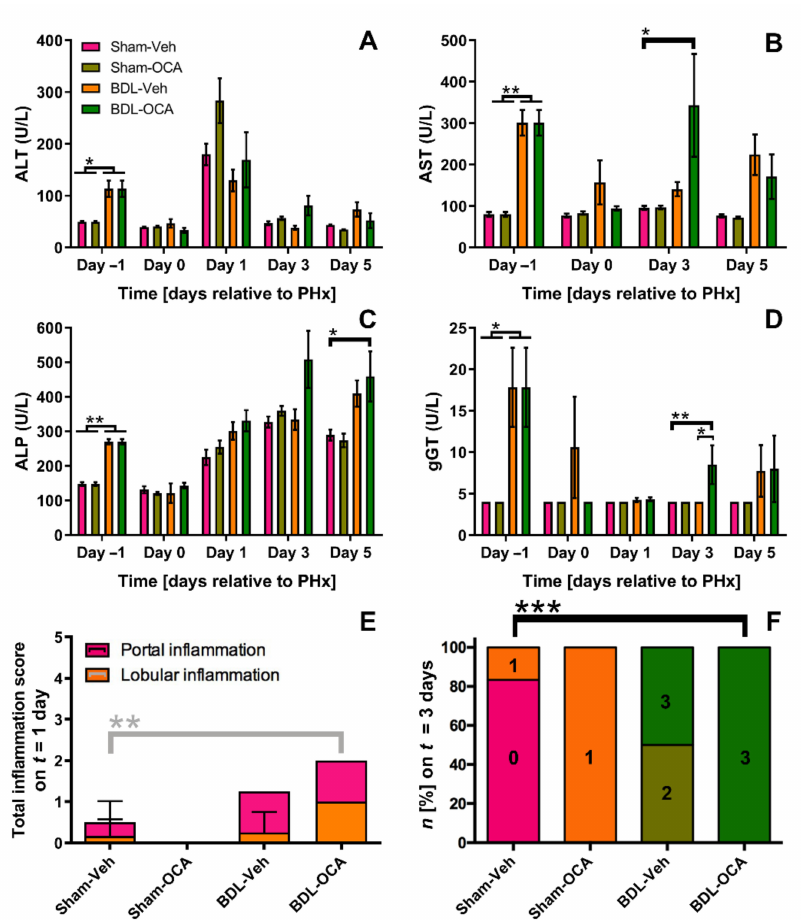
Figure 6. Obeticholic acid does not aggravate hepatobiliary injury caused by BDL. ( A – D ) Ala- nine transaminase (ALT), aspartate transaminase (AST), alkaline phosphatase (ALP), and gamma- glutamyltransferase (gGT) serum levels expressed in units/liter. Data represent mean ± SEM. ( E ) Total inflammation score 1 day after PHx expressed as the sum of the scores for portal inflammation and lobular inflammation (Table S2). Data represent mean ± SD. ( F ) Types of fibrosis seen in each group 3 days after PHx. 0 = none; 1 = mild periportal fibrosis; 2 = moderate periportal fibrosis; 3 = bridging fibrosis (<50%). Significance was assessed using a Mann–Whitney U test (for t = − 1 day) or a Kruskal–Wallis test with Dunn’s multiple comparisons test (for t = 0, 1, 3, and 5 days). * indicates p < 0.05; ** indicates p < 0.01; *** indicates p < 0.001. BDL, bile duct ligation; Veh, vehicle; OCA, obeticholic